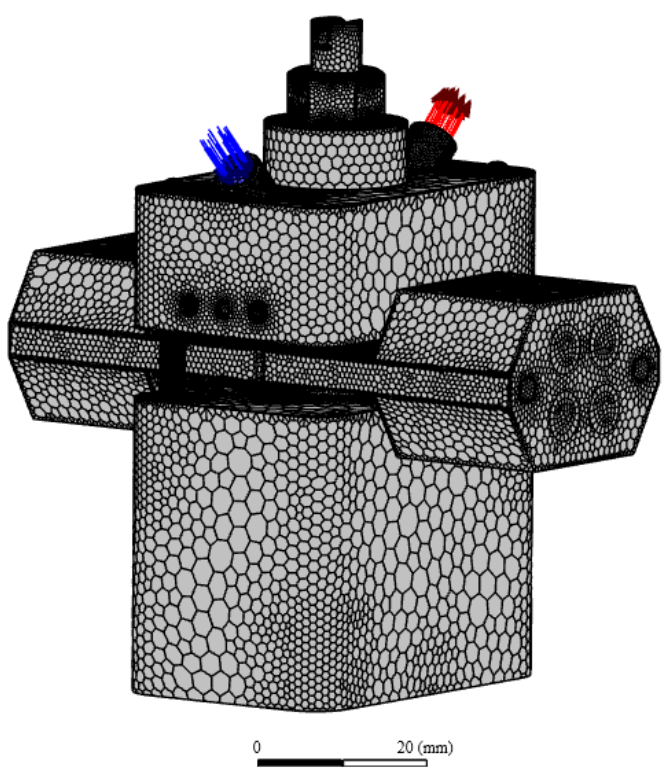
Figure 2. The model with polyhedron mesh, use in numerical simulations.